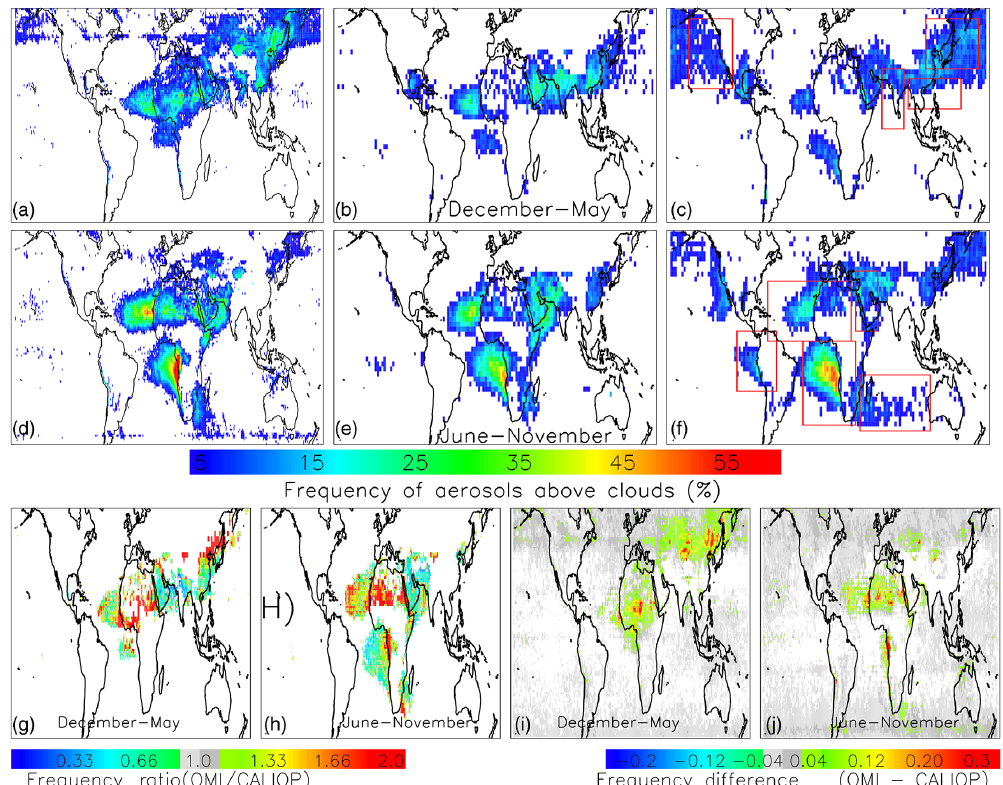
Figure 3. (a) Seven-year (December 2006 to May 2013) daytime cloudy-sky frequency of occurrence of aerosol above-cloud events during December through May defined from OMI (ratio of completely cloudy MODIS pixels with AI greater than 1.0 to the number of completely cloudy MODIS pixels with valid AI retrievals). (b) Daytime cloudy-sky frequency of occurrence of ACA events over cloudy skies from CALIOP (ratio of CALIOP pixels with CALIOP AOD abovecloud >0.015 to the number of CALIOP pixels with column-integrated COD>0) for the same temporal domain as (a) . (c) Nighttime cloudy-sky frequency of occurrence defined similar to the daytime frequency from (b) . Panels (d–f) show the same information as (a–c) but instead during June 2006 to November 2013. Panels (g, h) depict the ACA frequency ratio, defined as the OMI-MODIS daytime cloudy-sky frequency divided by the CALIOP-derived daytime cloudy-sky frequency, for the December to May and June to November periods, respectively. Panels (i, j) depict the difference in cloudy-sky frequency used to construct the frequency ratio plots (g, h) for the same temporal ranges. The red boxes show the areas selected for regional studies. Only OMI and CALIOP bins with frequency of 5% or higher are shown in this